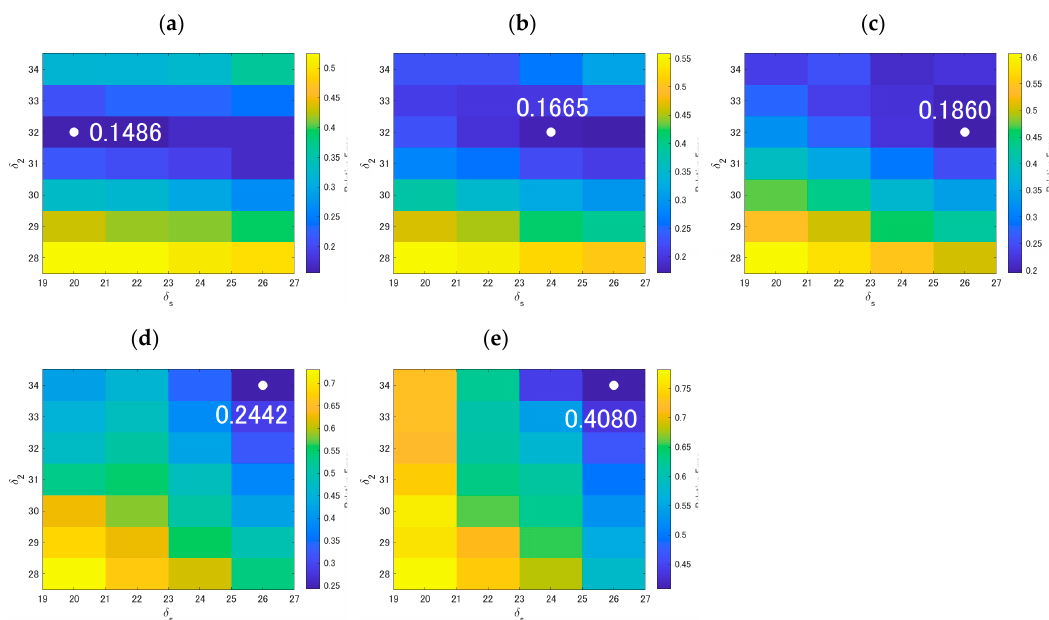
Figure 11. The relative error of velocity on the δ s and δ 2 plane for particle diameters ( a ) d = 10 cm, ( b ) d = 3.8 cm, ( c ) d = 1 cm, ( d ) d = 1 mm, and ( e ) d = 0.1 mm. The white circles show the minimum error position in each plane. The number in each plane is the minimum relative error value.